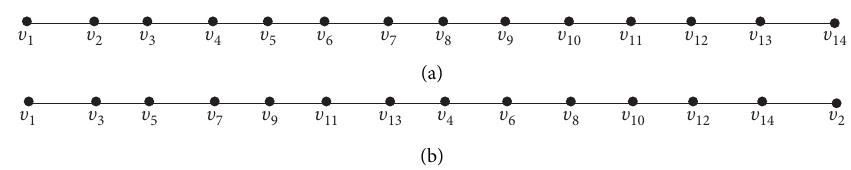
Figure 6: (a) A path with of 14 nodes; (b) the path after rearrangement of the nodes.